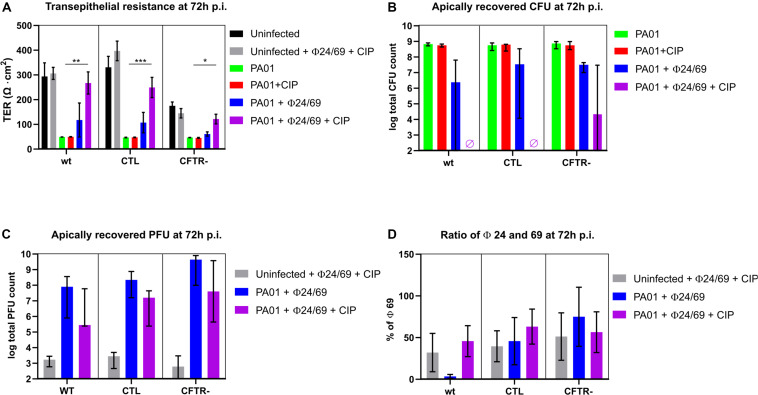
Measurement of trans-epithelial resistance (TER), CFU and PFU at 72 h p.i. (A) Only combined phage and ciprofloxacin (CIP) treatment protected epithelial cells from PAO1 infection (violet bars). (B) No viable bacteria (detection limit of 102 CFU/well) were recovered from the apical side of the wild type and CTL cells, while surviving bacteria occurred in 2/3 experiments on the cftr-cells. (C) Phages remained at the level of the inoculum in the absence of bacteria (gray bars) but replicated in the presence of PAO1 treated with phages alone (blue bars). CIP reduced phage replication due to killing of PAO1 host cells. (D) Phages were added at t = 0 h at a 50:50 ratio. With the exception of the wild type cell line (blue bar), this ratio was maintained until 72 h p.i. Values represent mean and SEM (panels A,D), and median and range (panels B,C) of three independently performed experiments. Differences in TER between the conditions were assessed using a one-way ANOVA; *p < 0.05, **p < 0.01, ***p < 0.005.